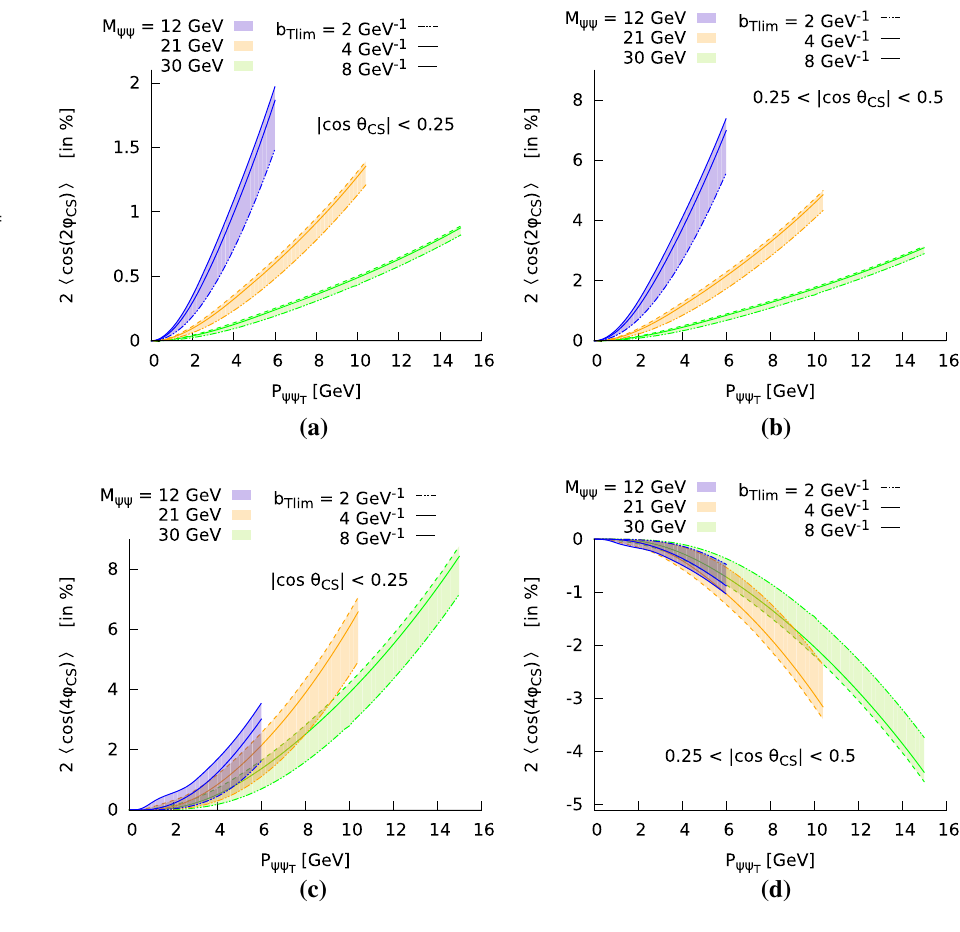
Fig. 4 The azimuthal asymmetries for di- J /ψ production as functions of P QQ T . The different plots show 2 (cid:13) cos ( 2 φ CS ) (cid:14) (a,b)